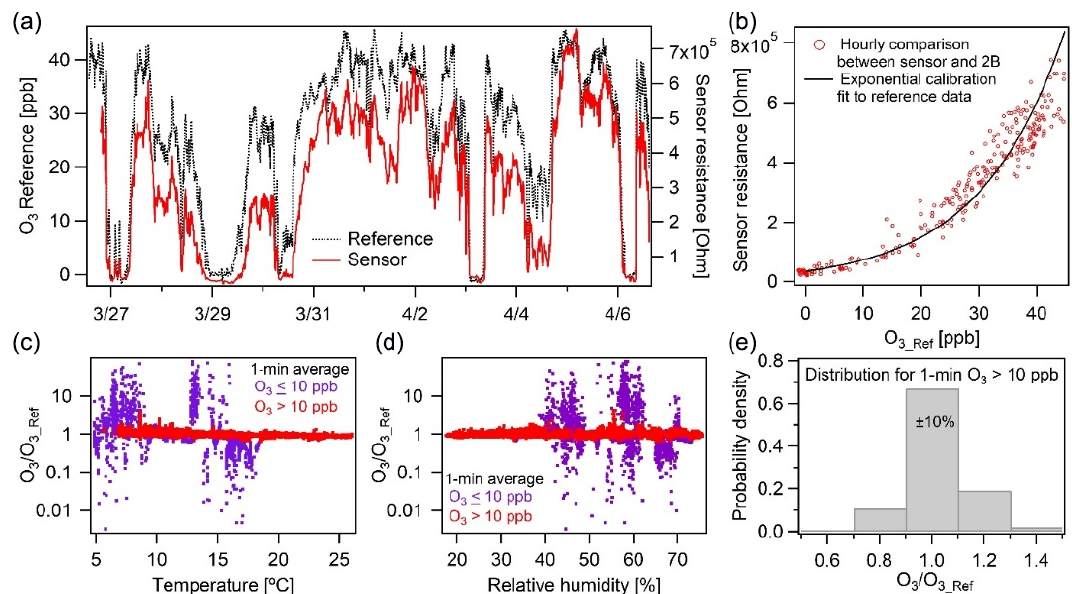
Figure 6. Ozone calibration performance and evaluation (a) over 2 weeks in New Haven, CT, shown and (b) calibrated against a 2B Tech reference monitor (note panel a shows sensor resistance, not concentration). (c–d) The ratio of our calibrated vs. reference measurement for concentrations greater and less than 10ppb over the range of RH and temperatures observed, with no dependence on RH and a slight temperature dependence. (c–d) At concentrations greater than 10ppb our measurements are much more accurate, (e) with 70% of the 1min average data falling within ± 10%.